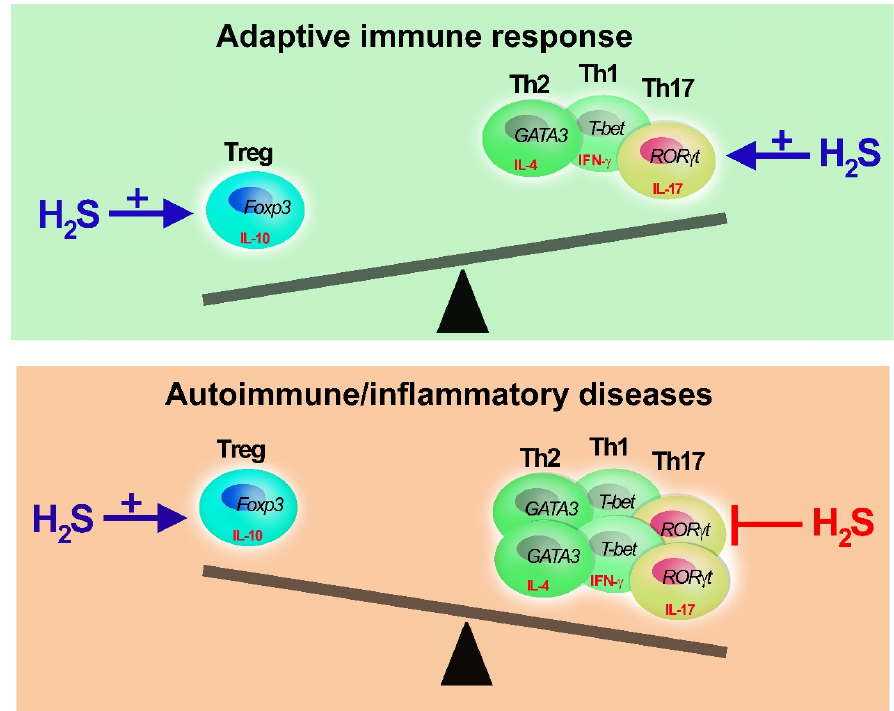
Figure 3. Adaptive immune response, H 2 S buffering activity. Hydrogen sulfide can restore the equilibrium of Th and Treg cells. H 2 S is needed to develop appropriate Th-mediated immune response promoting Th and Treg polarization and functions. In case of excessive Th1, Th2 or Th17 activation (unbalanced of immune response), as in immune-mediated diseases, H 2 S promotes Treg proliferation (+) and inhibits ( − ) Th activity and expansion. However, when H 2 S reaches millimolar doses, it has immunosuppressive activities impairing T cell proliferation and cytokine secretion.